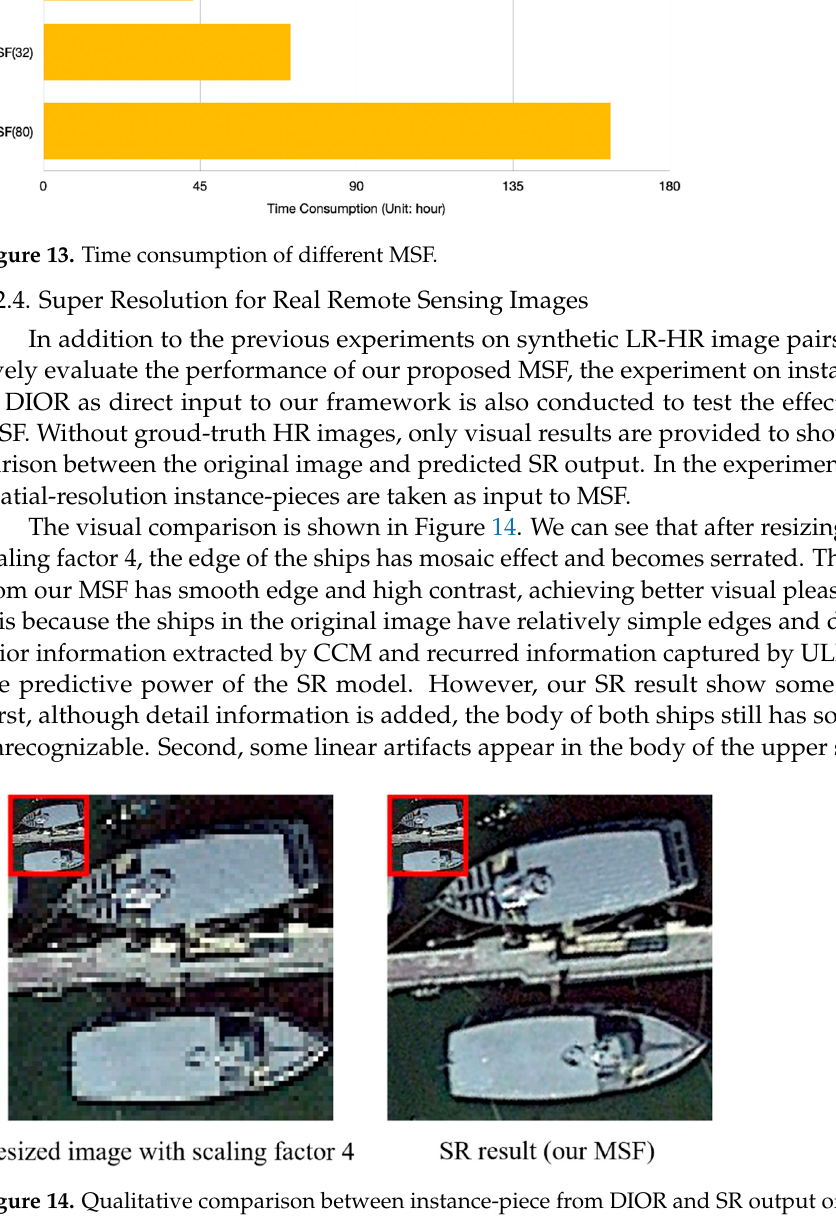
Figure 12. Comparison among MSF with different number of subordinate networks after data augmentation step; the green part is the increase obtained by data augmentation.